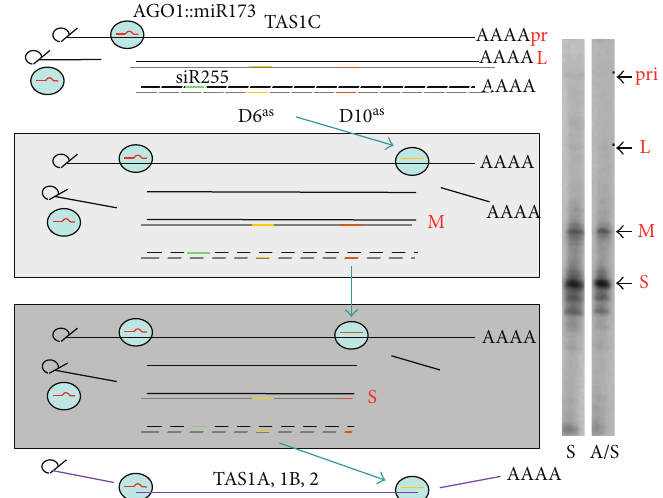
F 9: Cascades involving TAS1 and TAS2 processing in Arabidopsis . e results rely on the use of CaMV infected plants of which the suppressor TAV interferes with the DCL4/DRB4 activity. e dsRNA intermediates generated by RDR6 accumulating in CaMV infected plants were analyzed. For TAS1c, three main dsRNAs accumulated. e largest and minor one corresponds to a single cut of TAS1c RNA by